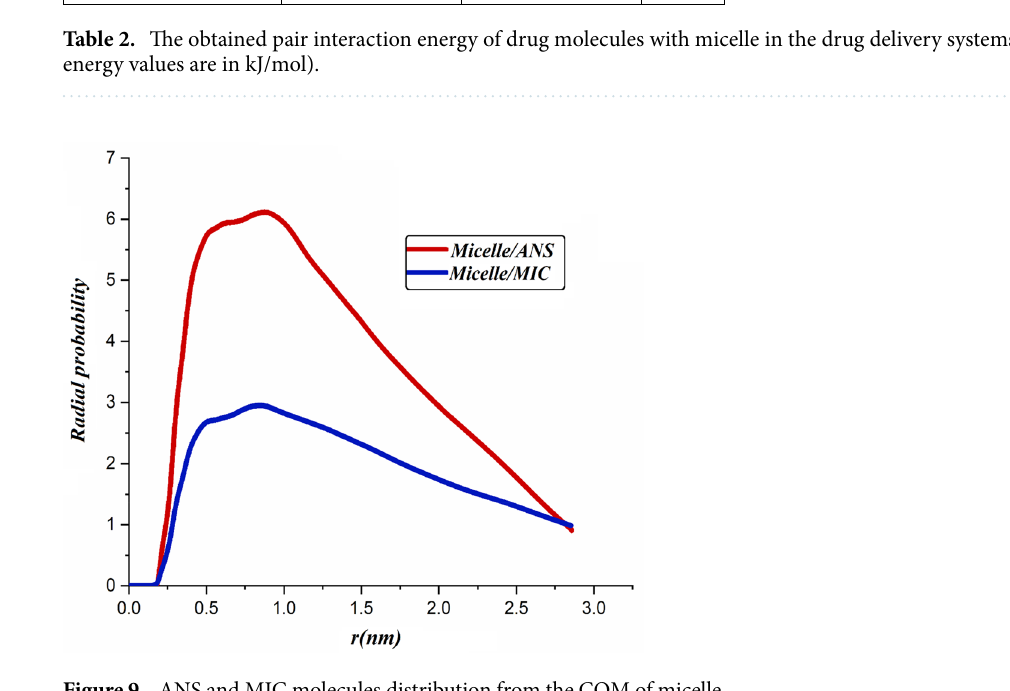
Figure 9. ANS and MIC molecules distribution from the COM of